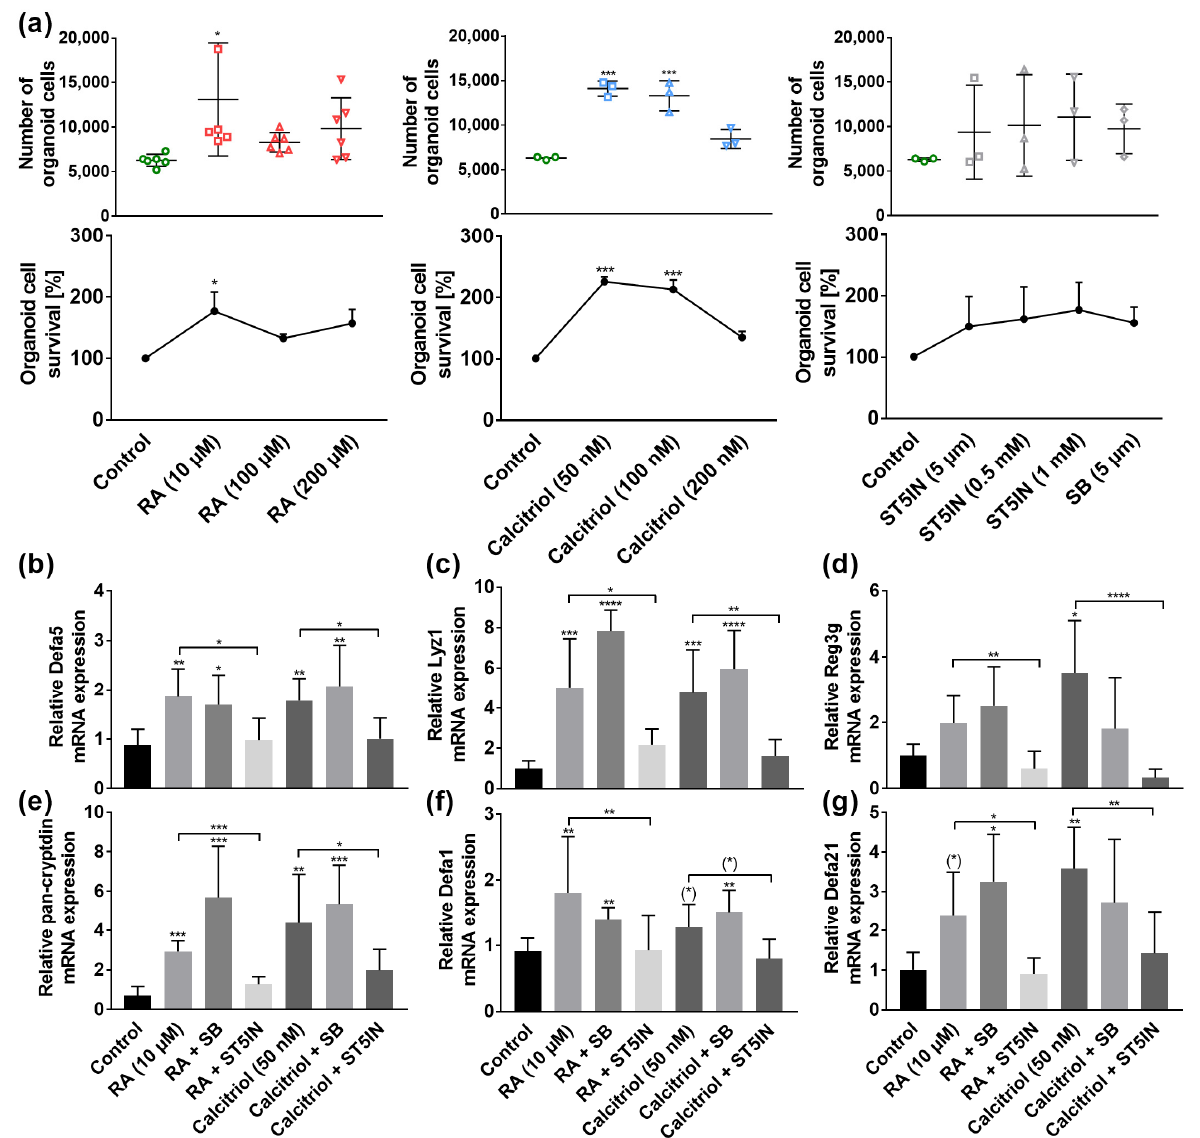
Figure 5. Retinoic acid (RA) and calcitriol regulate AMPs in murine organoids in vitro through STAT5 signaling pathway. For MTT assay, organoids were treated with RA (10 µ M, 100 µ M, 200 µ M), calcitriol (50 nM, 100 nM, 200 nM), ST5IN (5 µ M, 0.5 mM, 1 mM) or with SB (5 µ M) for 30 h. The total number of organoids and cell survival by quantification of fluorescence signals are shown ( n = 3–6) ( a ). Organoids were treated with RA (10 µ M) or calcitriol (50 nM) in combination with ST5IN (5 µ